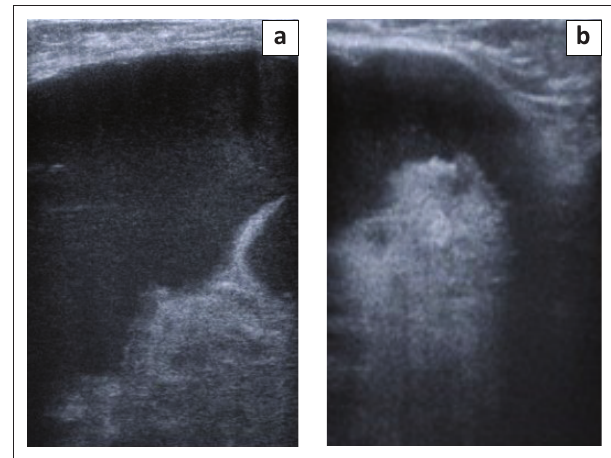
FIGU RE 2: Axial/transverse view (a) and sagittal/ longitudinal view (b) of the left breast on initial ultrasound, demonstrating a large anechoic mass with multiple septations and irregular walls with